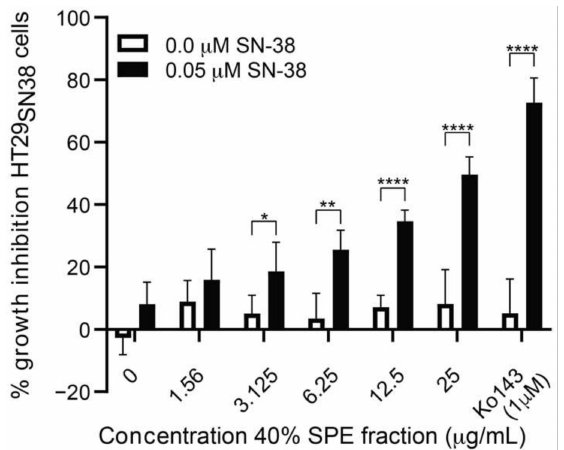
Figure 4. Growth inhibition (relative to untreated controls) of HT29 SN38 cells treated with different concentrations of 40% SPE fraction, either alone or in combination with 0.05 µ M SN-38. Ko143 at 1 µ M was used as a positive control (duplicates performed in 3 biological replicates). Error bars indicate SD determined on the basis of n = 6. * p ≤ 0.05, ** p ≤ 0.01, **** p ≤ 0.0001.